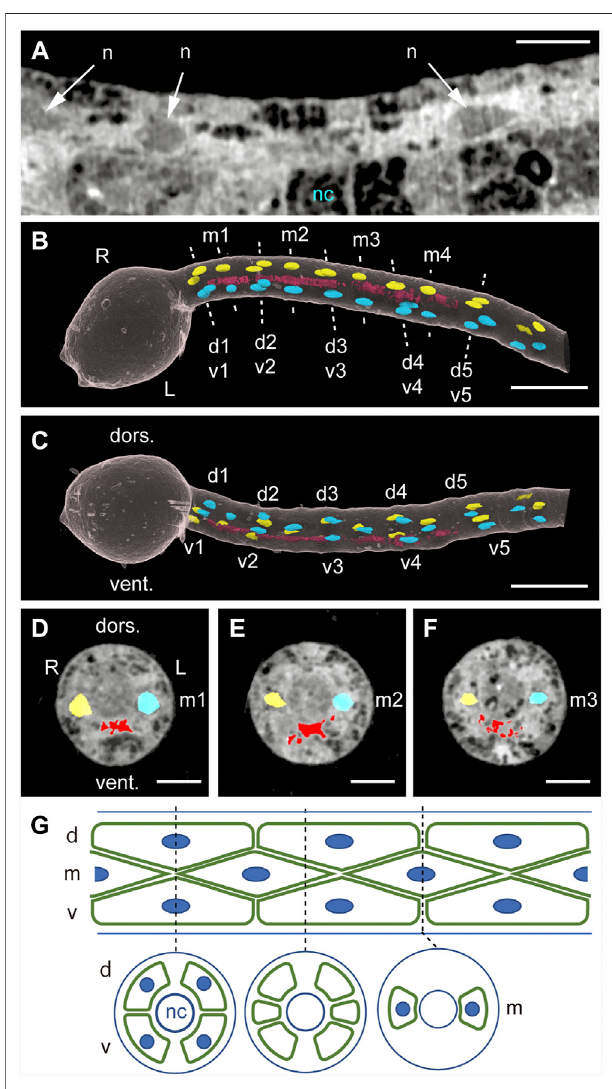
FIGURE 2 | Bilateral positions of muscle cell nuclei as analyzed by quantitativeX-raytomographicmicroscopy. (A) Horizontal sectionofthetailin a Ciona 16-hpflarva. n, muscle cellnucleus. nc, notochord. Scalebar, 10 μ m. (B) Dorsal view of positions of muscle cell nuclei pseudo-colored blue (leftside)andyellow(rightside).red,ventralhigh-densitystructure.Threerows of dorsal (d), middle (m), and ventral (v) muscle cells are numbered from anterior to posterior. Scale bar, 50 μ m. (C) Left lateral view. dors., dorsal. vent.,ventral.Scalebar,50 μ m. (D – F) Anteriorviewsofverticalcross-sections at nuclei of m1, m2, and m3 muscle cells. Scale bar, 10 μ m. (G) Schematic lateral and cross-sectional views of muscle cells (green) and nuclei (blue).